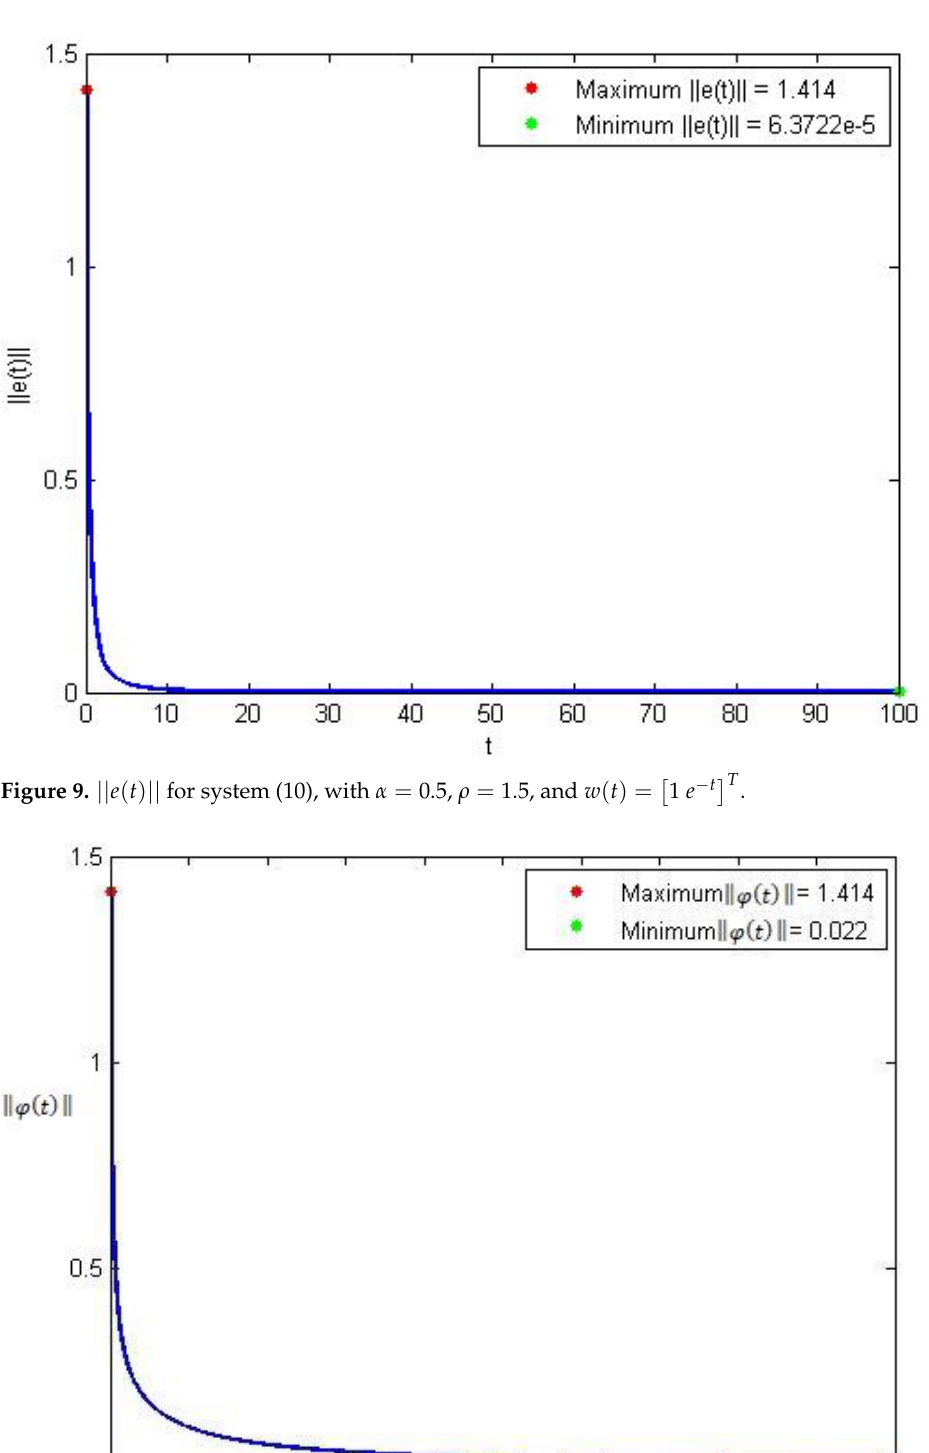
(cid:2) (cid:3) T 1 e − t